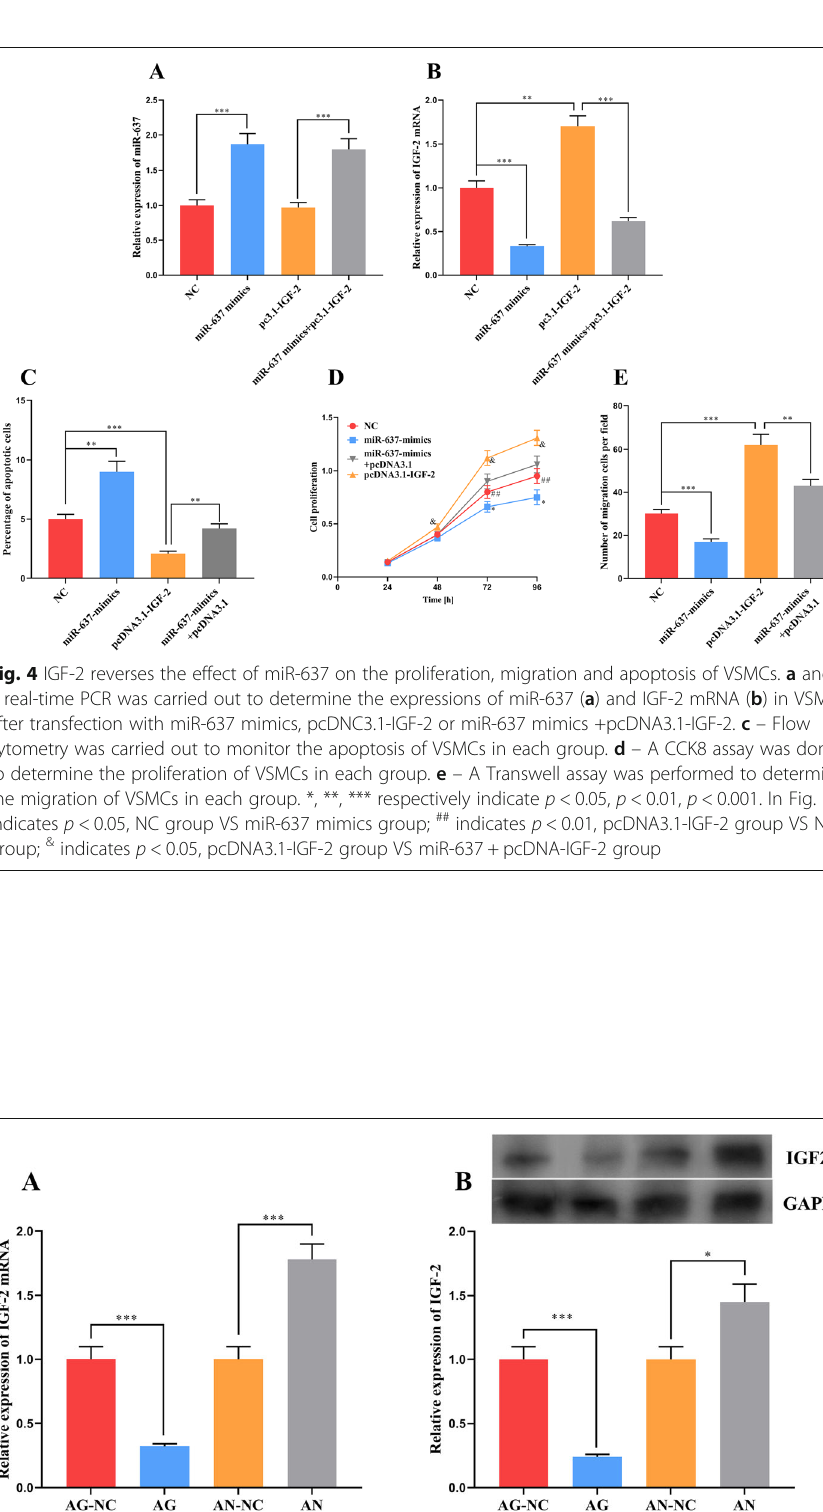
Fig. 5 The effect of miR-637 in mice. a – Real-time PCR was done to detect changes in IGF-2 mRNA after miR-637 agomir or miR-637 antagomir were injected into the tail vein of the mice. b – Western blotting was performed to detect changes in IGF-2 after miR-637 agomir or miR-637 antagomir were injected into the tail vein of the mice. AG-NC: miR-637 agomir negative control; AG: miR-637 agomir; AN-NC: miR-637 antagomir negative control; AN: miR-637 antagomir. *** indicates p <